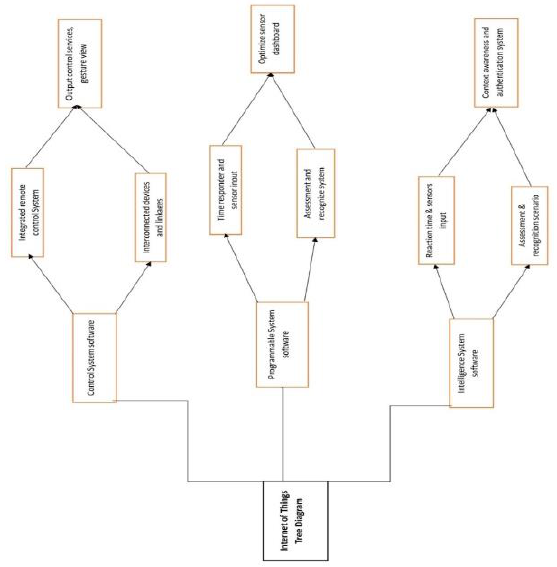
Figure 2. Stages of system